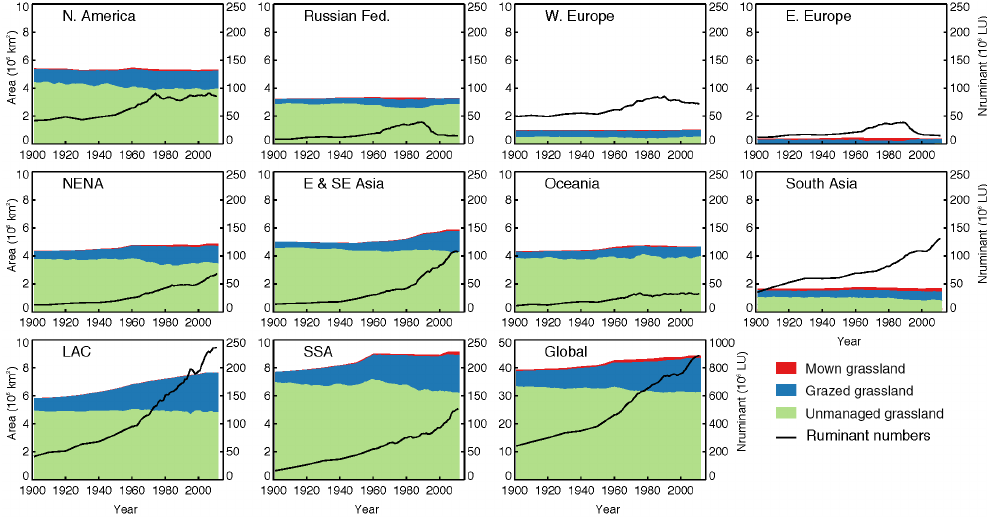
Figure 5. Historical changes in the area of managed/unmanaged grassland and in the ruminant numbers for 1901 and 2012 by region and global total. See caption to Table 2 for expansion of FAO-defined